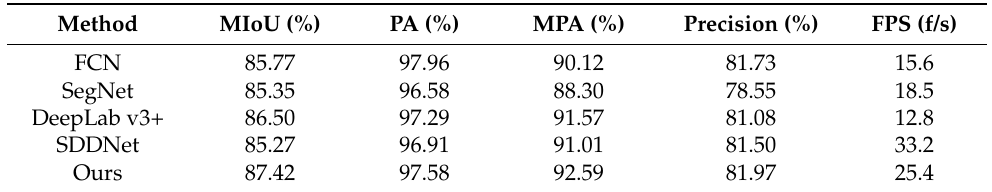
Figure 8. Predicted results compared with ground truth, the images ( a – e ) are randomly selected from the test set. Table 1. Comparison of Performance for Different Methods on Public Concrete Crack